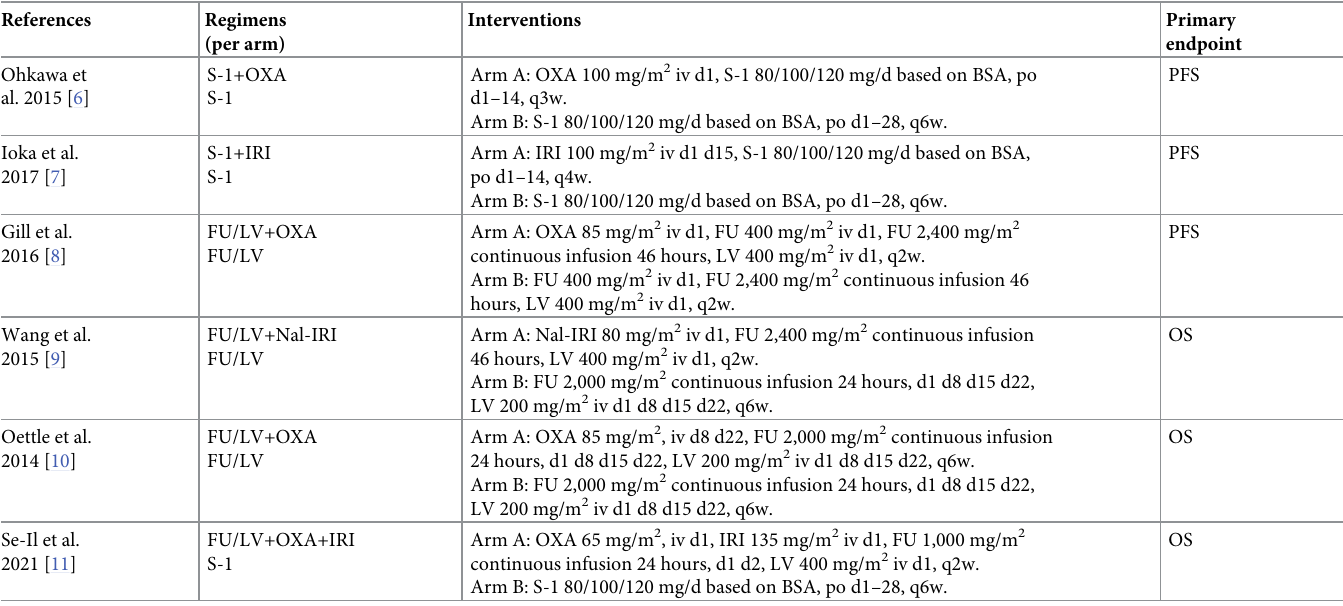
Table 3. Regimens and endpoints of included studies.